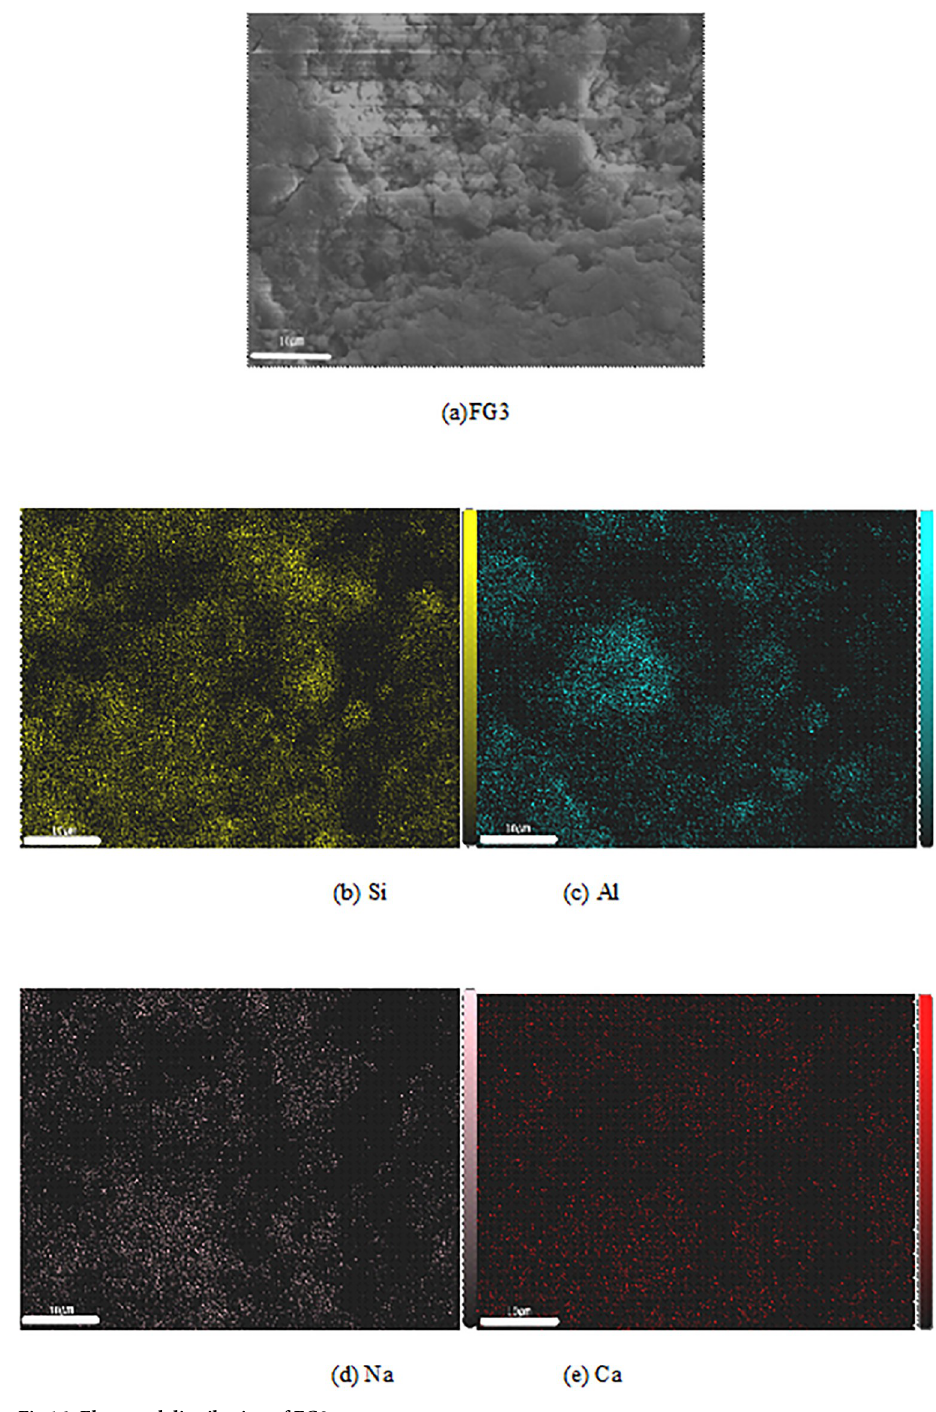
Fig 16. Elemental distribution of FG3.